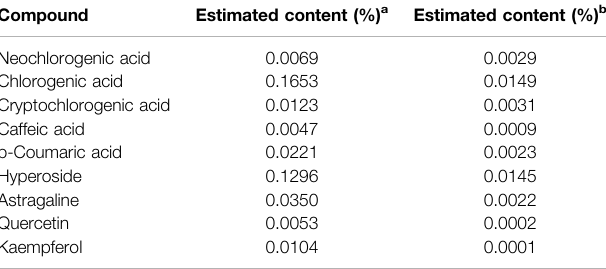
TABLE 2 | Estimated content of the major chemical components in CCL.